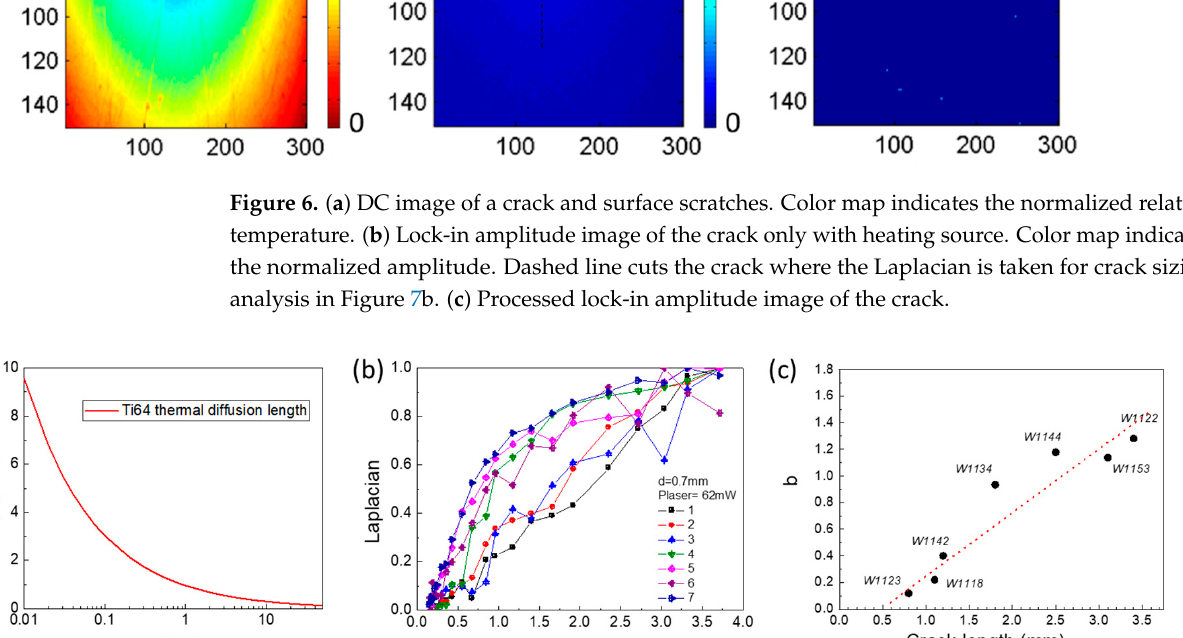
Table 2. Physical parameters of Ti64 Alloy.